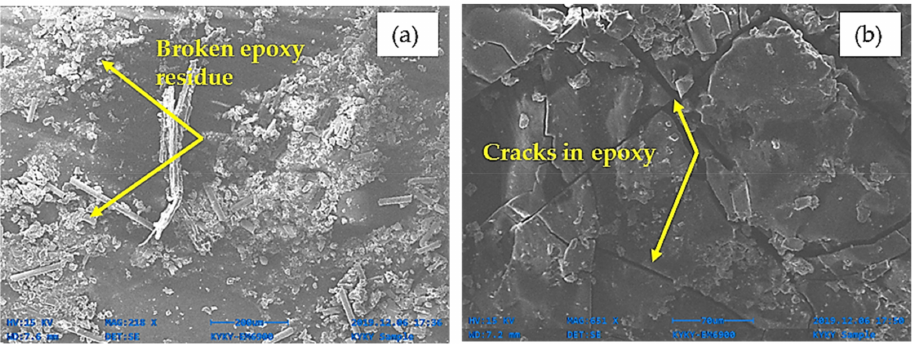
Figure 8. SEM images of 35-day water-aged specimens with magnification: ( a ) 218 × and ( b ) 651 ×